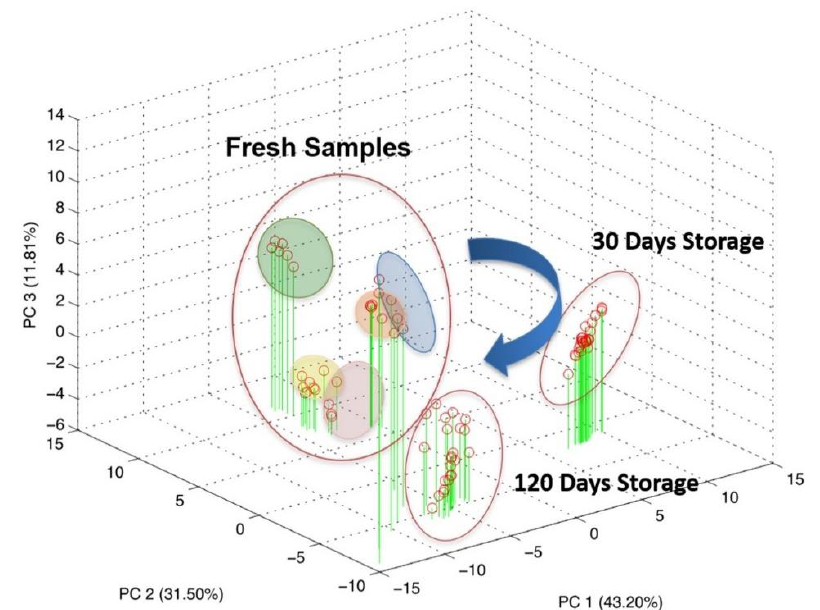
Figure 5. Scores plot of the principal component analysis on the overall dataset comprising both repeatability and reproducibility evaluation. repeatability and reproducibility